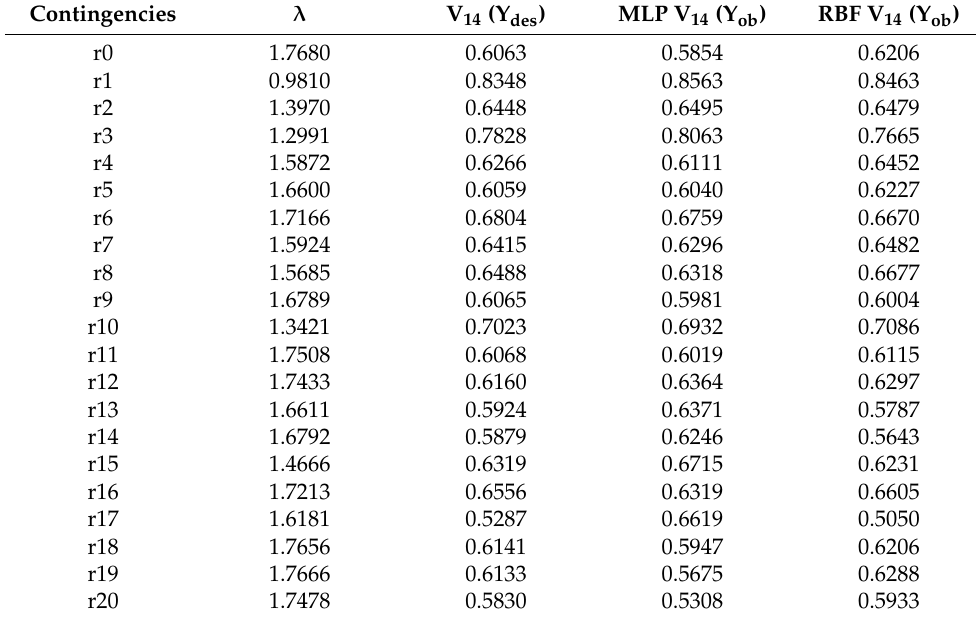
Table 2. Values of voltage magnitudes of the maximum loading point of bus 14 obtained via the MLP and RBF network for each